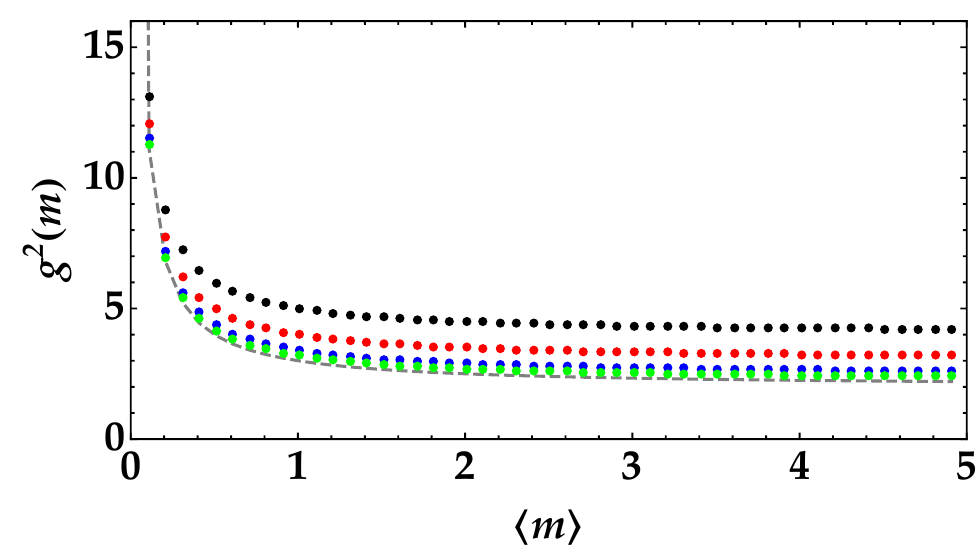
Figure 1. Second-order autocorrelation function g 2 ( m ) as a function of the mean number of photons for µ f = 1 and different values of µ s . Different colors refer to different choices of µ s . From top to bottom: black to µ s = 1, red to µ s = 2, blue to µ s = 5, and green to µ s = 10. The dashed gray curve corresponds to a single-mode thermal state of